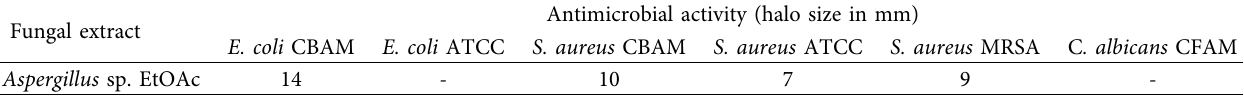
Table 1: Antimicrobial activity of Aspergillus sp. extract by the cup plate method with inhibition halos in mm. Antimicrobial activity (halo size in Fungal extract